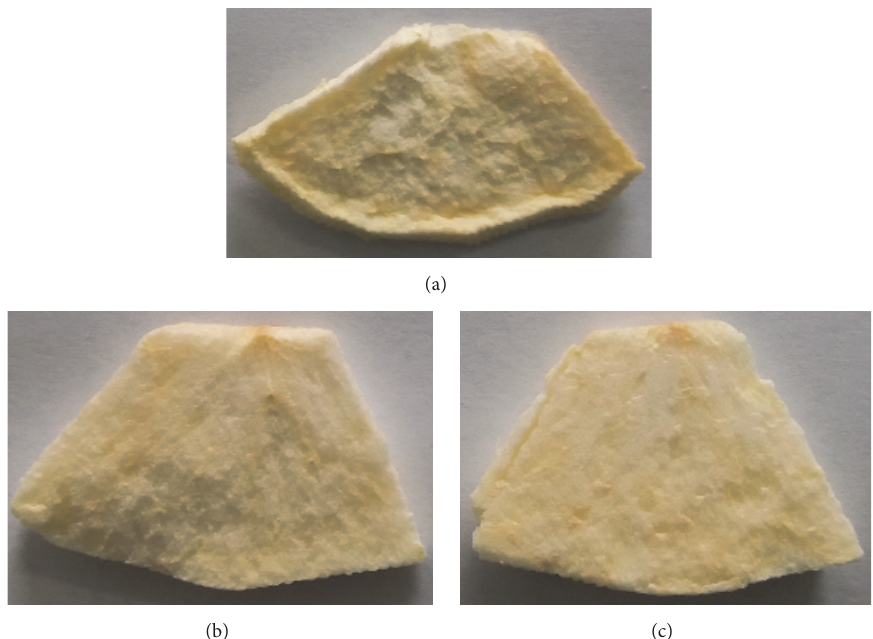
Figure 8: Apparent photographs of freeze-dried samples with 3 freeze-drying methods. (a) VF-FD; (b) HWB-VF-FD; (c) HWB-PF-FD. VF- FD: apple samples without hot-water pretreatment were performed with vacuum freezing treatment and freeze-drying process; HWB-VF-FD: apple samples with hot-water pretreatment were performed with vacuum freezing treatment and freeze-drying process; HWB-PF-FD: apple samples with hot-water pretreatment were performed with plate freezing treatment and freeze-drying process.